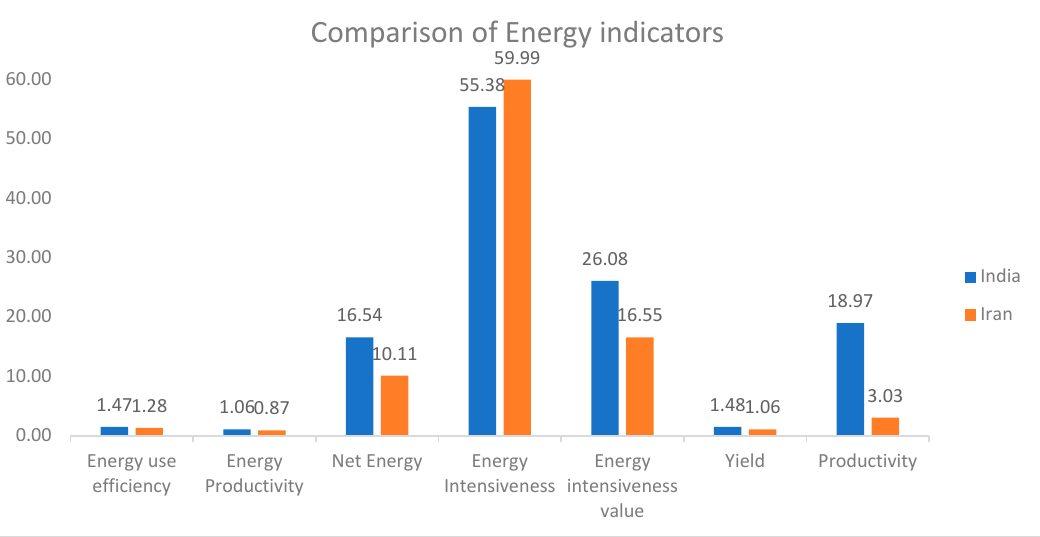
Figure 8. Comparison of energy indicators in biodiesel production for India and Iran.